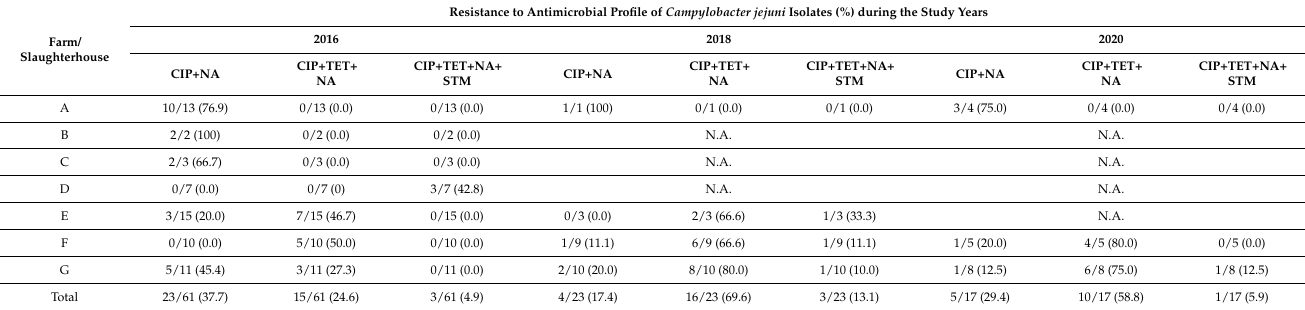
Table 3. Antimicrobial resistance profile of the isolated Campylocater jejuni strains (n =